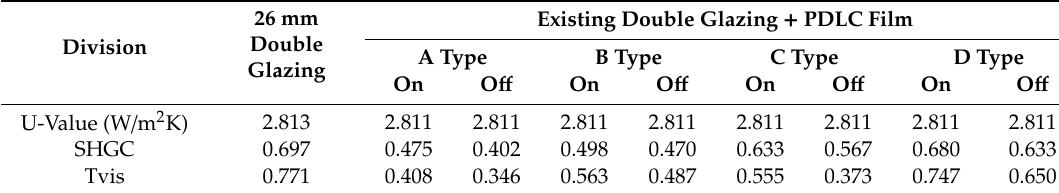
Table 5. Optical and thermal properties of double glazing with a PDLC film.